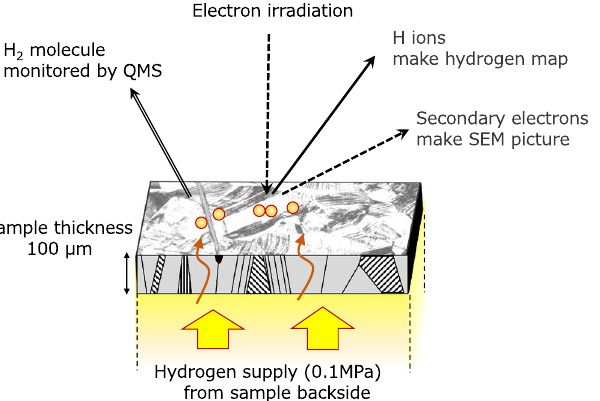
Figure 1. Schematic diagram of experiment set up of Operando Hydrogen Microscope. Hydrogen supplied from the one side of membrane sample, which is separating the experimental chamber into a hydrogen compartment and a ESD measurement compartment, permeates through the membrane to ESD measurement compartment. Permeated hydrogen is irradiated by electron beam, ionized and desorbed from the sample. The electron beam is also used to take a scanning electron microscope image (SEM image) with the emitted secondary electrons. The thermal desorbed hydrogen molecules can be monitored with a quadrupole mass spectrometer (QMS) 4